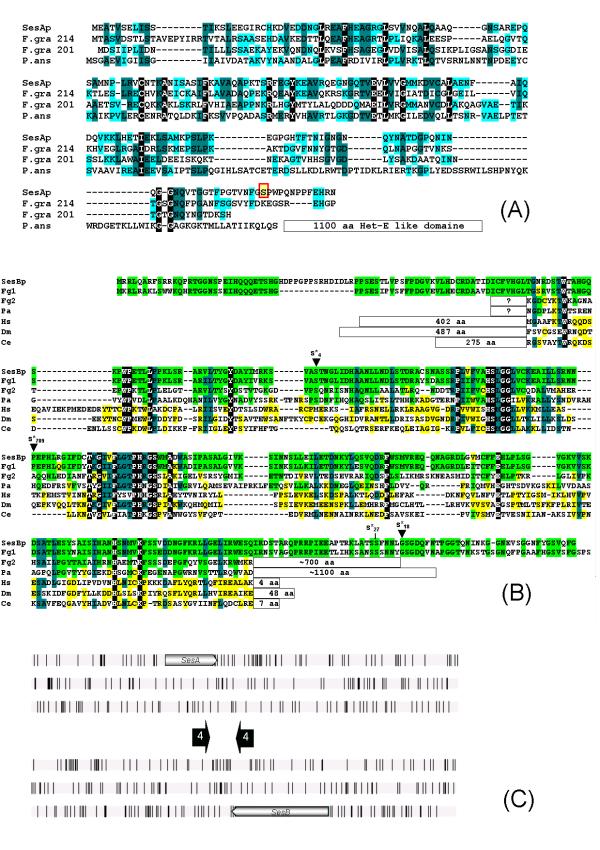
SesA and SesB conservation during evolution. (A) Alignment of SesAp with its homologues in Fusarium graminearum (F. gra 214 and F. gra 201) and Podospora anserina (P. ans). The amino acid change in s1 is boxed. (B) Alignment of SesBp with representative homologues from F. graminearum (Fg1 and Fg2; the sequence was obtained from the Fungal Genome Initiative, ), P. anserina (Pa; ), Homo sapiens (Hs; GENBANK: BC001705), Drosophila melanogaster (Dm; GENBANK: AAF5369), and Caenorhabditis elegans (Ce; PIR: T21079). Arrowheads indicate the amino acid changed in s*4, s*789, and s*18; arrow indicates the position of the frameshift in s*27. (C) Conservation of Ses organization in F. graminearum. SesA corresponds to F. gra 214 of (A) and SesB corresponds to Fg1 of (B). Percentages of identity with Nectriahaematococca SesAp and SesBp are 41% and 79%, respectively. In (A) and (B), conserved amino acids are shaded. Color reflects the degree of conservation.